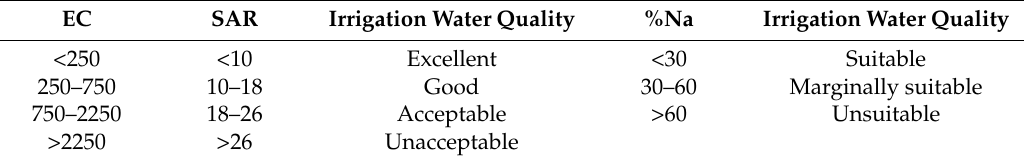
Table 3. Criteria of irrigation water quality classifications based on EC, SAR, %Na and RSC.